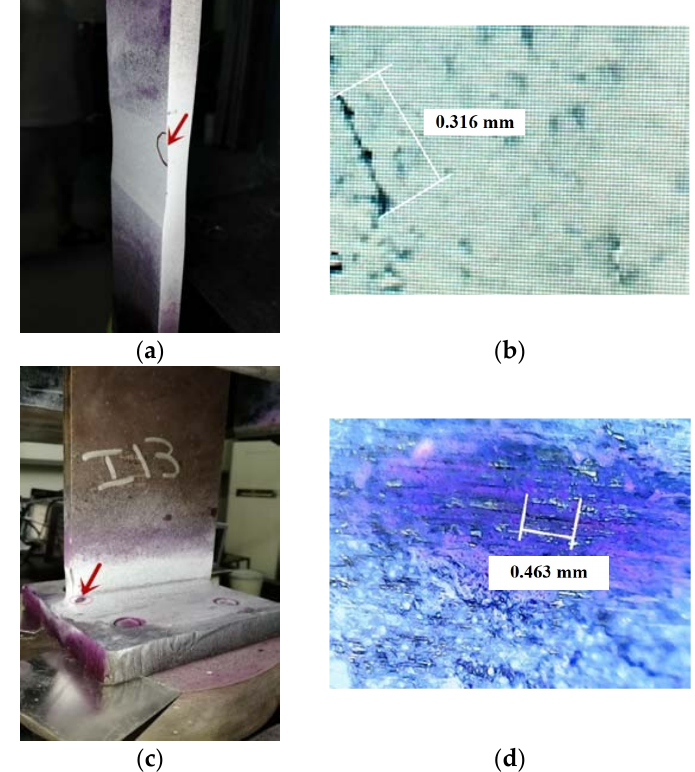
Figure 7. Crack locations in the specimens: ( a ) welded steel plates (B03), ( b ) crack detected in the welded steel plates (B03), ( c ) T-type welded steel plates (113), and ( d ) crack detected in the T-type welded steel plates.